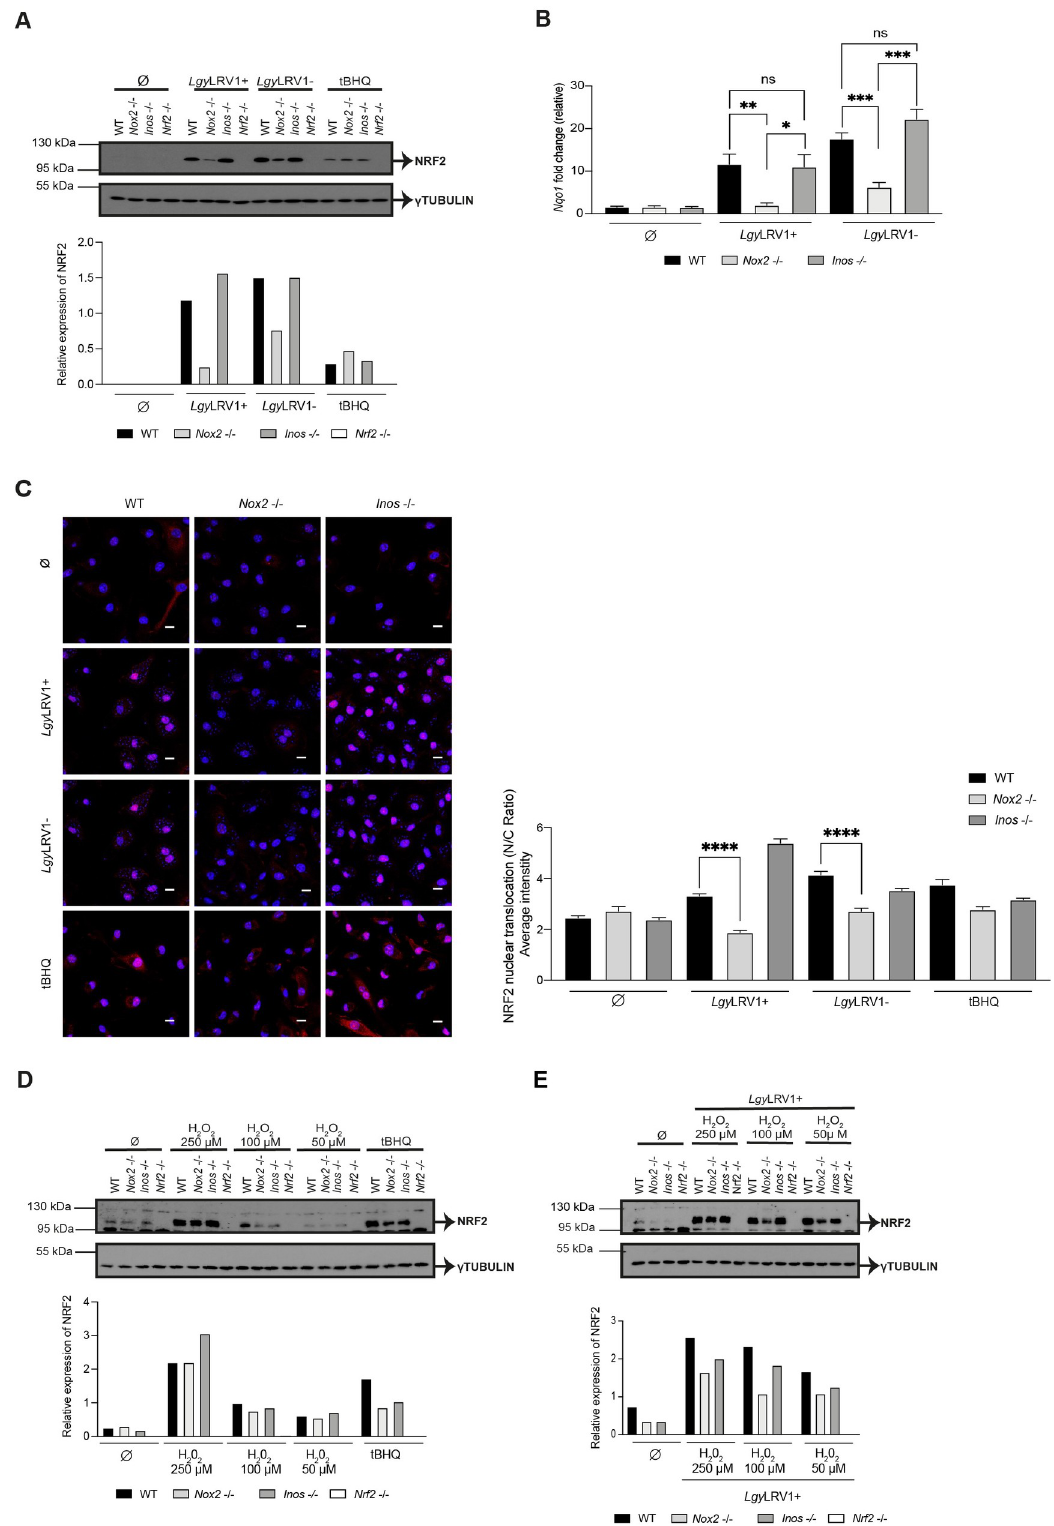
Fig 4. NOX2 promotes NRF2 signaling through ROS in Lgy LRV1+ and Lgy LRV1- infections. BMDMs from WT, Nox2 -/- , Inos -/- and Nrf2 -/- mice were either non-stimulated ( Ø ), or infected with Lgy LRV1+ or Lgy LRV1- parasites, or stimulated